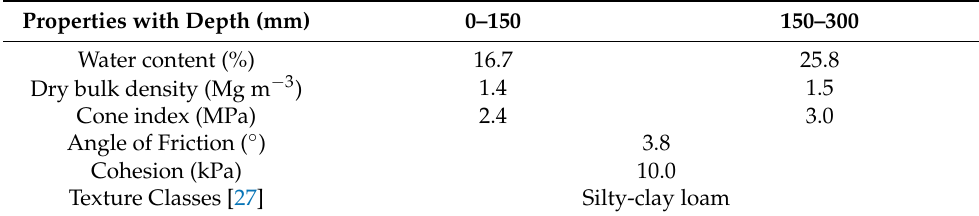
Table 1. Pre-tillage field soil physical and mechanical properties. Properties with Depth